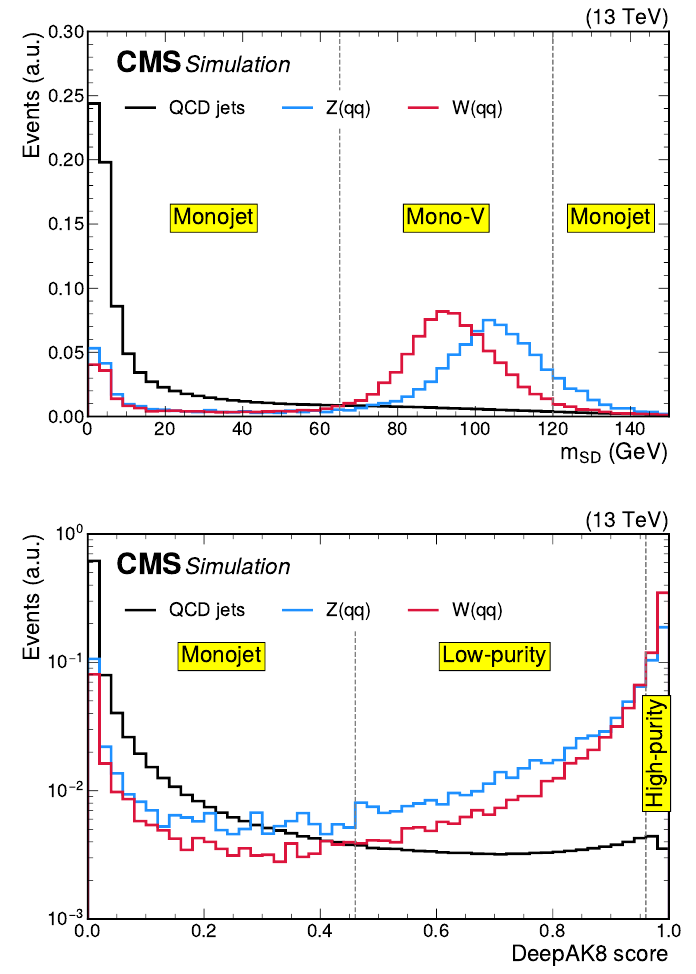
Figure 23 . Distributions of the variables used for the identification of V → qq candidate jets. The upper and lower panels show the SD-corrected jet mass and the DeepAK8 classifier value, respectively. In each panel, the distributions are shown for the Z → nn background, as well as the WH (inv.) and ZH (inv.) signals. The distributions are shown after applying the mono-V signal region selection, with the exception of the requirements on the two variables shown here. Vertical dashed lines indicate the acceptance boundaries of different